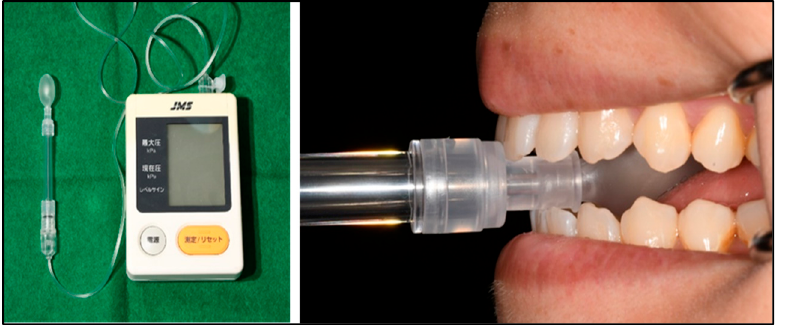
Figure 1. Measurement of Maximum Tongue Pressure (MTP). The device is composed of a measure- ment box, probe, and connecting tube. The balloon type probe was inflated with air at an initial pressure of 19.6 kPa by turning on the switch for pressurization. The diameter of the balloon was approximately 18 mm, and the volume was 3.7